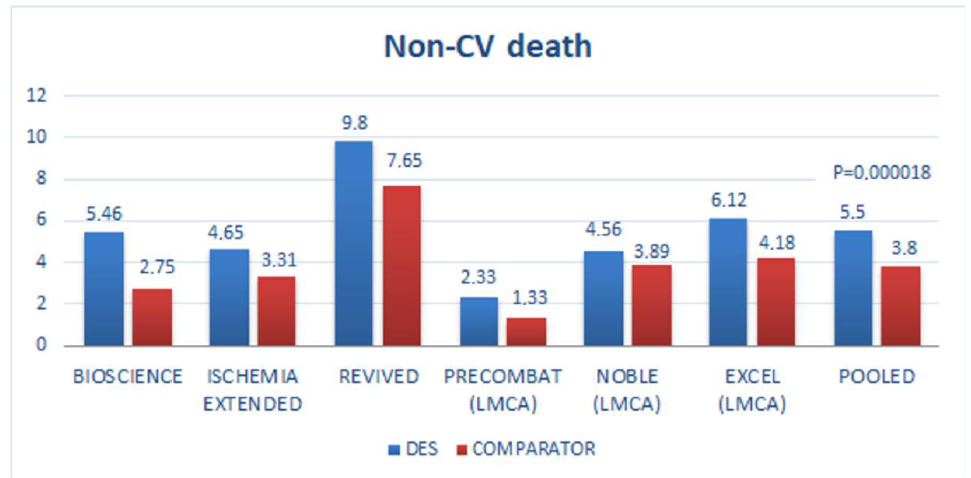
Figure 2. Randomized clinical trials with DES, non-cardiovascular death (non-CV death at long-term follow-up.) The last bar is the average of trial results. Significant differences in non-CV death ( p = 0.000018 in favor of comparator). Acronyms, abbreviations, and trial designs are described in Figure 1.